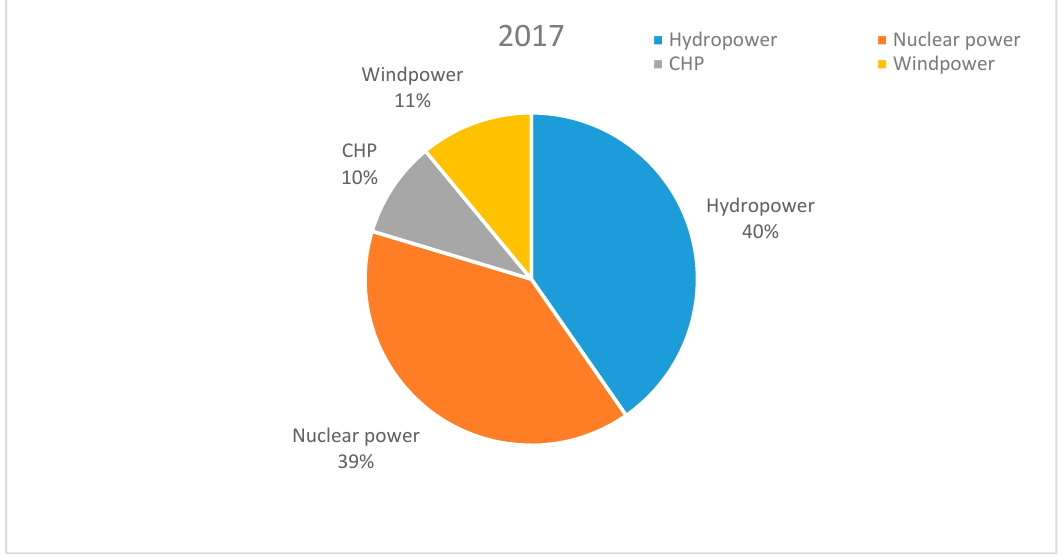
Figure 1. Total electricity production in Sweden 2017 [1].